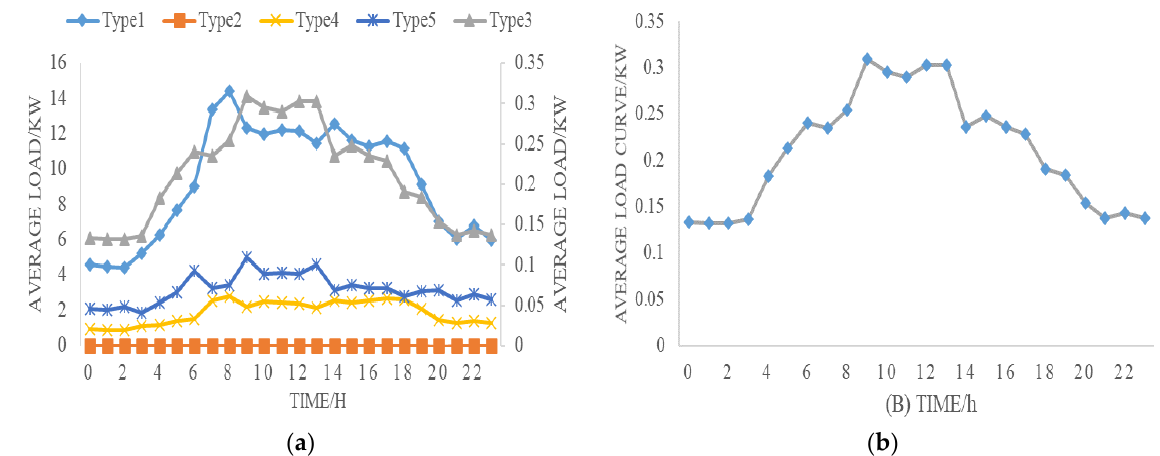
Figure 5. The load curve in February ( a ) clustered 5 types of loads; ( b ) the type 3 load.